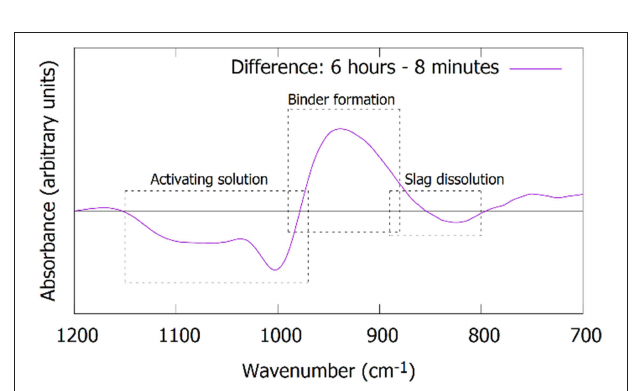
FIGURE 7 | Difference plot of the FTIR spectra after 6h compared to 8min, revealing more clearly the changes: (1) transformation of the activating solution, (2) the formation of the binder phase, and (3) the dissolution of the